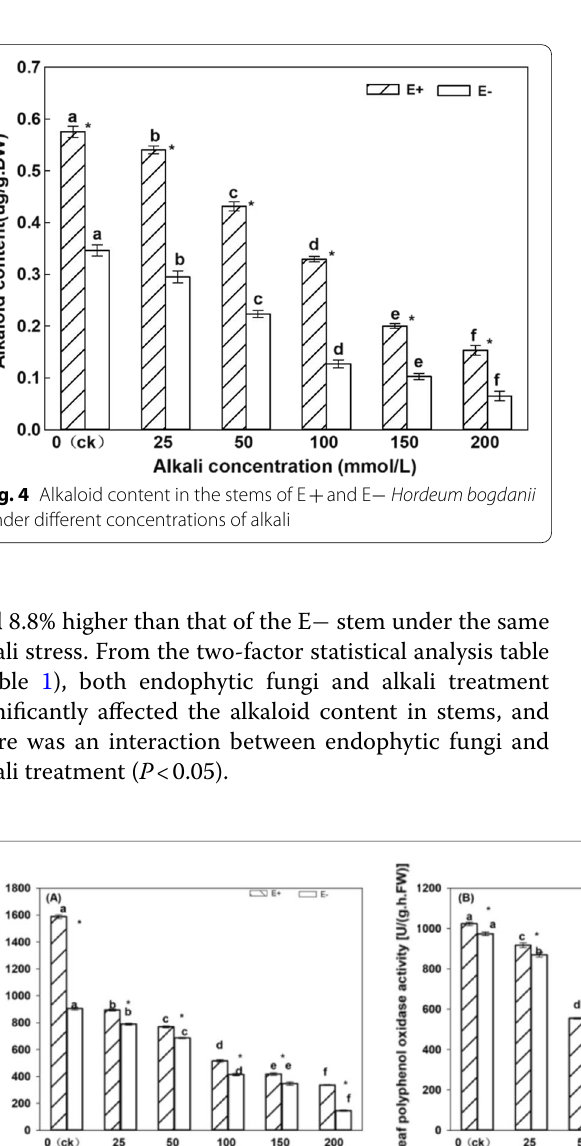
and E Hordeum bogdanii under different + −